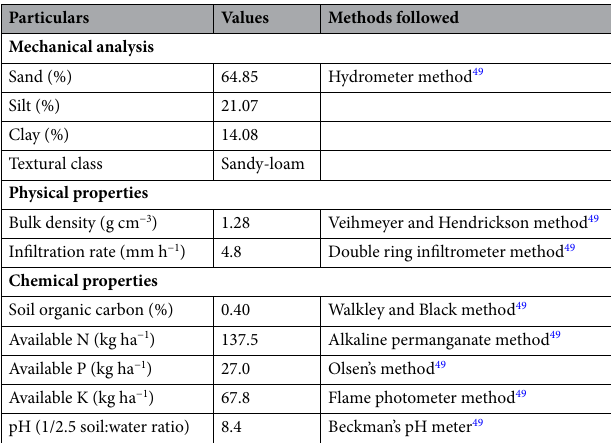
Table 4. Physical and chemical properties of the experimental soil.